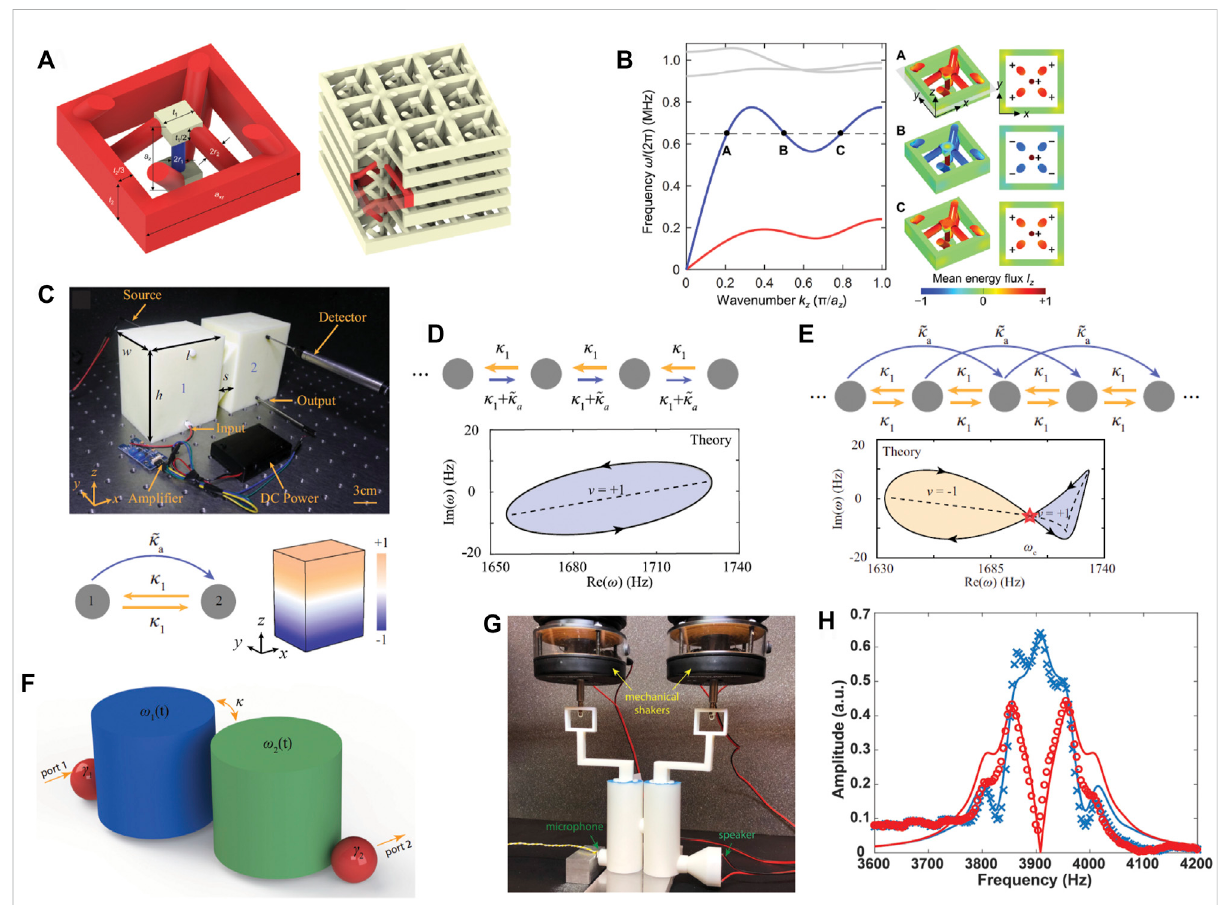
FIGURE 12 Emerging research using coupled resonators. (A) Long-range coupling in coupled resonators. (B) Non-local oddities by the long-range coupling. (C) Asymmetricresonantcouplingincavityresonators. (D) Windingnumberinnonreciprocalnearest-neighborcoupling. (E) nonreciprocal long-range coupling. (F) Time modulated resonance coupling. (G) Resonance modulation. (H) Nonreciprocal wave transmission for the forward (blue) and backward (red) directions. Reprint (A,B) from Ref. [70]; (C – E) from Ref. [71]; (F – H) from Ref.